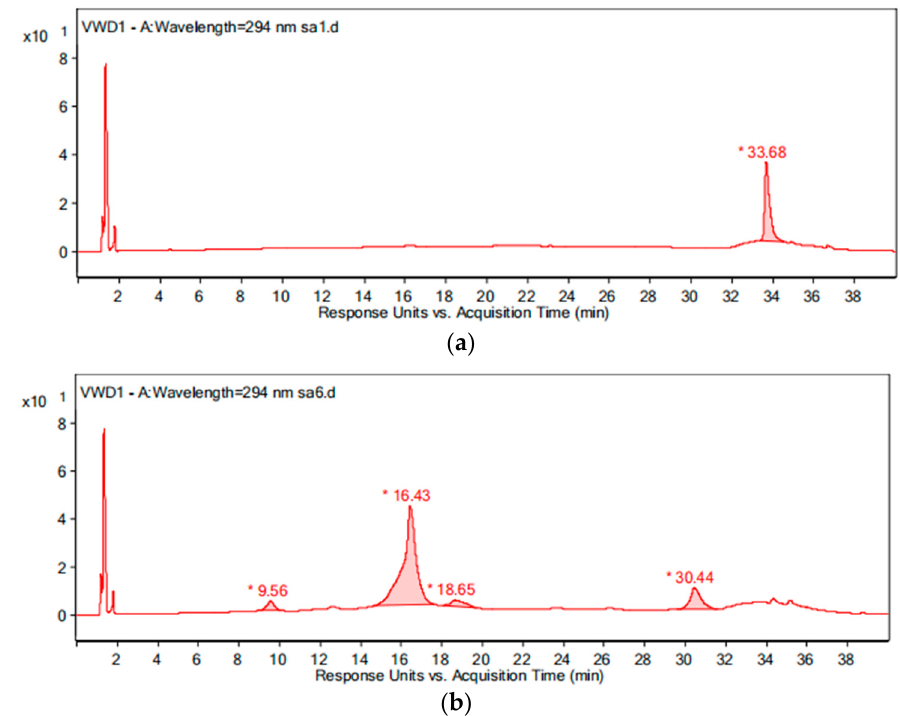
Figure 12. The chromatogram of the water sample at reaction times of: ( a ) 0 h and ( b ) 24 h.